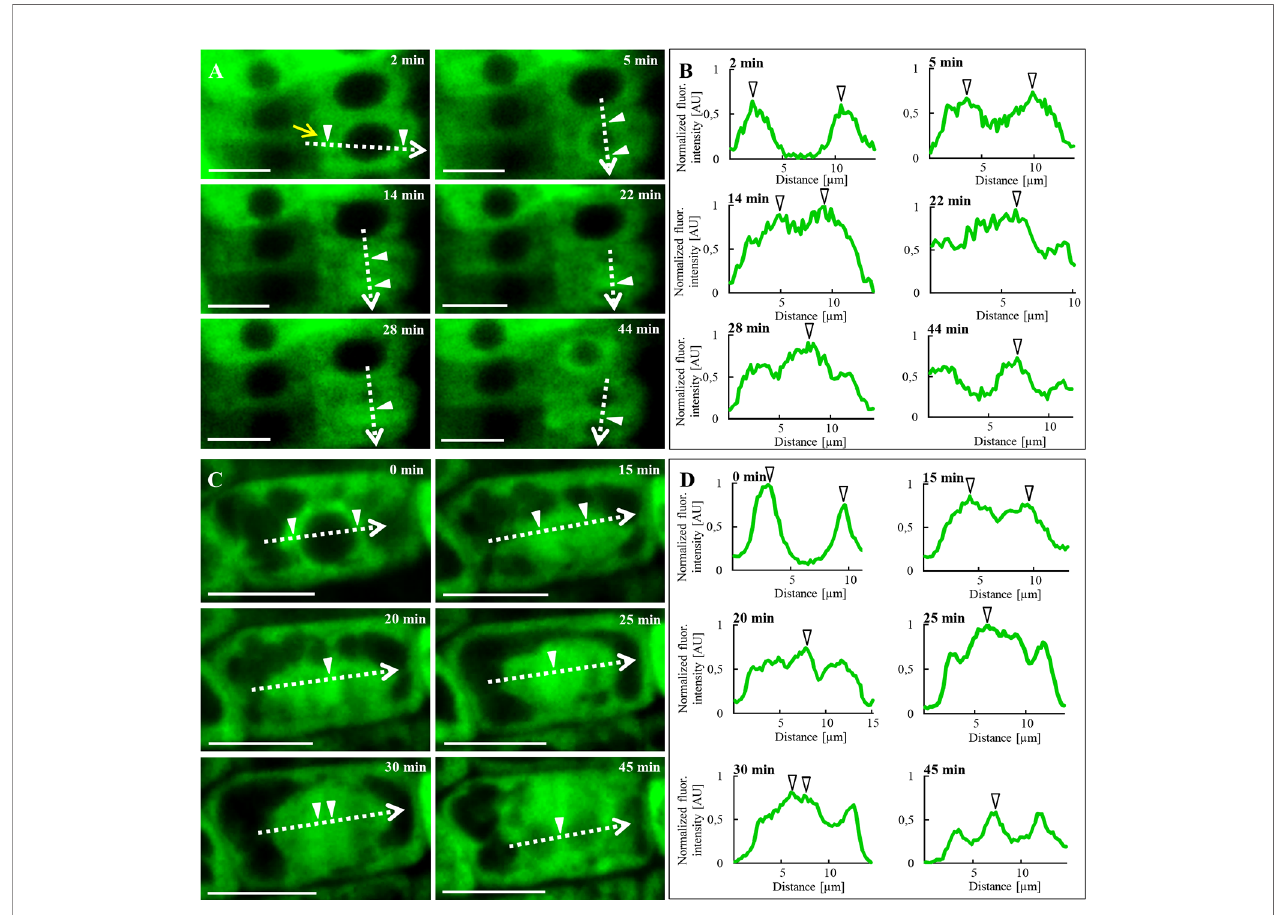
FIGURE 9 | In vivo time-lapse imaging of subcellular localization of ANN1-GFP during cell division in transgenic A. thaliana expressing proANN1::ANN1:GFP construct using LSFM. (A) Redistribution of ANN1-GFP in dividing root epidermal cell. At the initial stage (2 min), ANN1-GFP was present at the pre-prophase band of microtubules (yellow arrow). Later on (5 min), ANN1-GFP was enriched around the nucleus before and at the time of mitotic spindle formation (14 min). Next, it relocated to early (22 and 28 min) and late phragmoplast (44 min). (C) The analogous pattern of ANN1-GFP relocation and association with mitotic and cytokinetic microtubule arrays was recorded in dividing lateral root cap cell. (B, D) Fluorescence intensity pro fi les of ANN1-GFP distribution were measured along indicated dotted arrows at respective cell division stages. Arrowheads [white in (A, C) and black-bordered in (B, D) ] indicate a maximum of measured fl uorescence intensities. Scale bars = 10 m